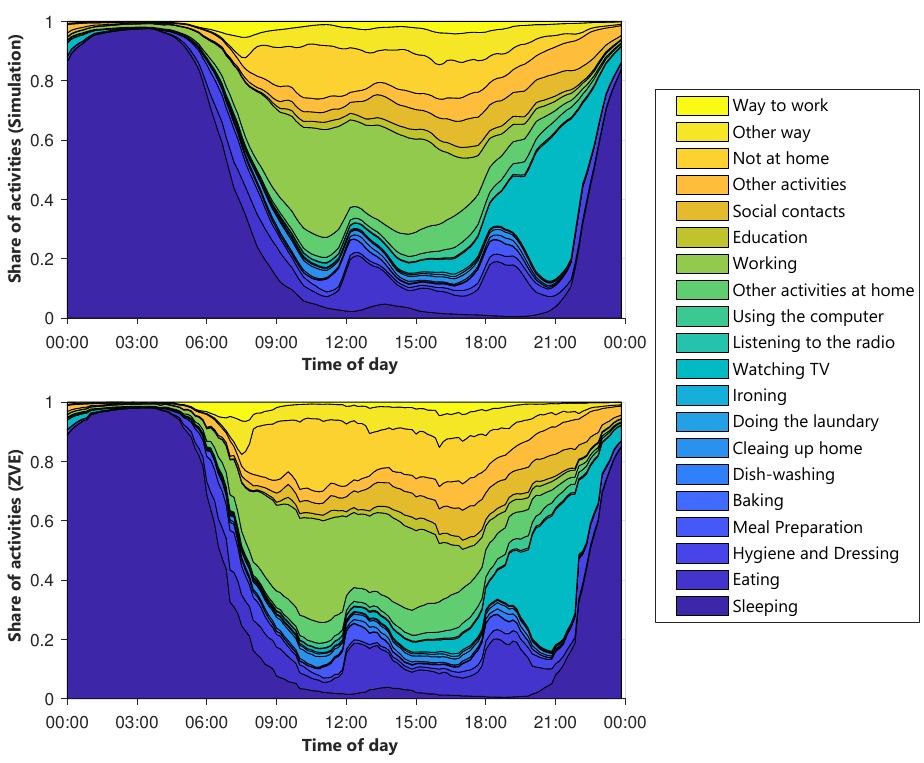
Figure A1. Average layered course of the activities for Monday till Thursday.